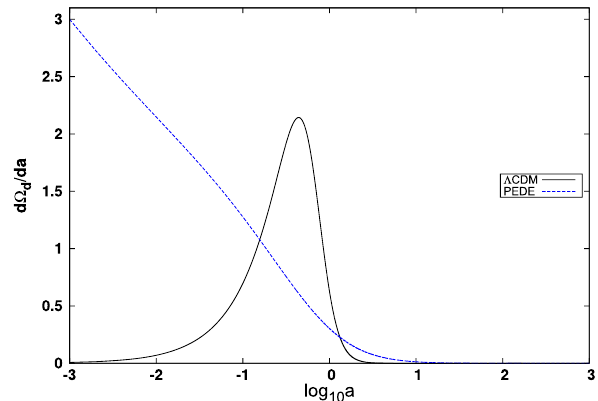
Fig. 1 The evolution of d (cid:4) d / da , the rate of changes of (cid:4) d , as a func- tion of the scale factor a . We set (cid:4) m , 0 = 0 .